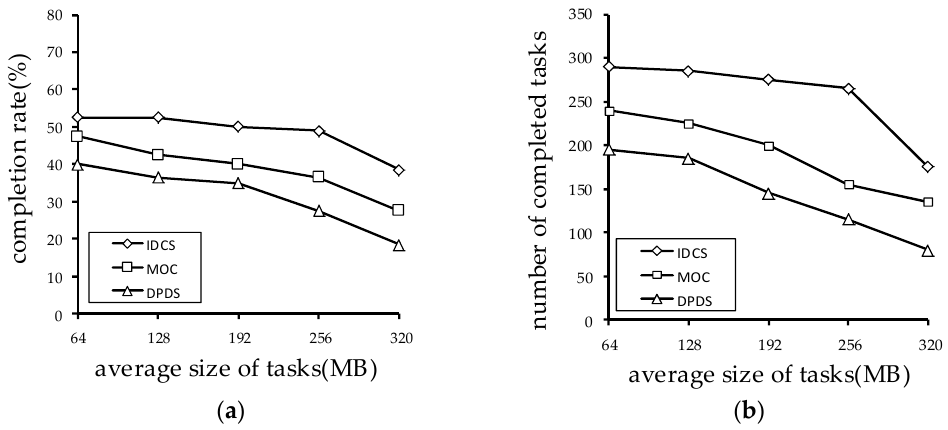
Figure 8. The impact of the average size of the tasks on the performance of the algorithms: ( a ) The impact of average size of tasks on task completion rate; ( b ) the impact of the average size of tasks on number of the tasks completed.